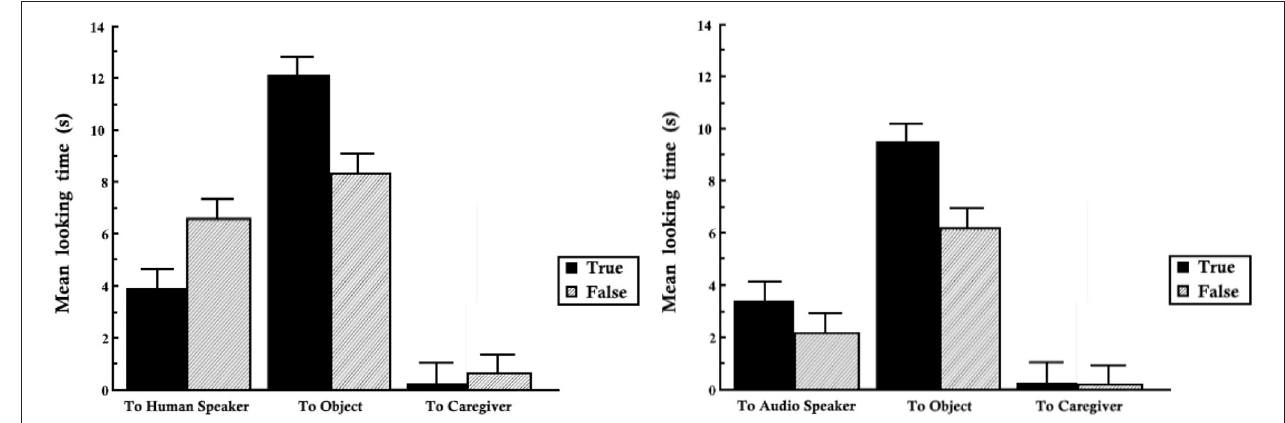
FIGURE 2 | Looking time to parent, label source, and label target for true and false labels from human (experiment one, left ) and audio speaker (experiment one, right